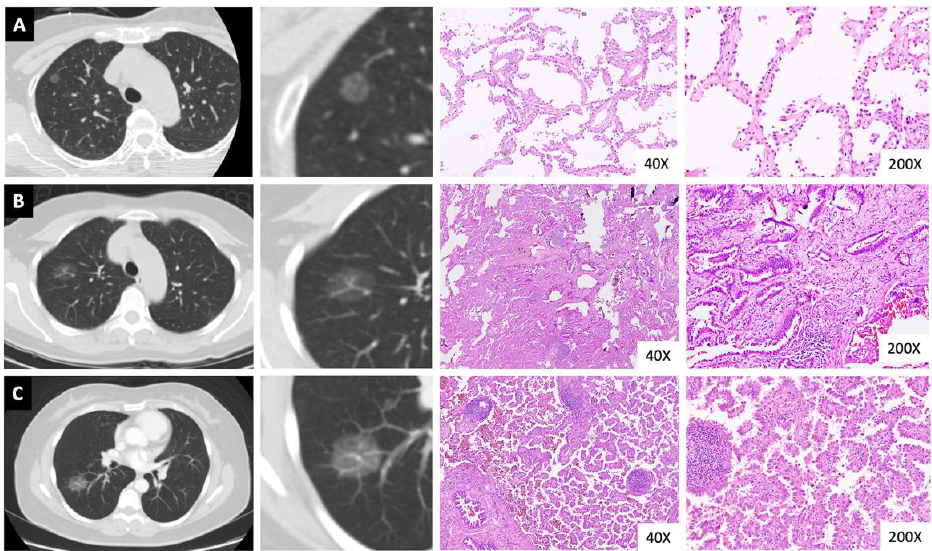
Figure 3. Computed tomography images with the corresponding microscopic pathology images. Rep- resented cases: ( A ) adenocarcinoma in situ, ( B ) minimally invasive adenocarcinoma, and ( C ) papillary predominant invasive adenocarcinoma.